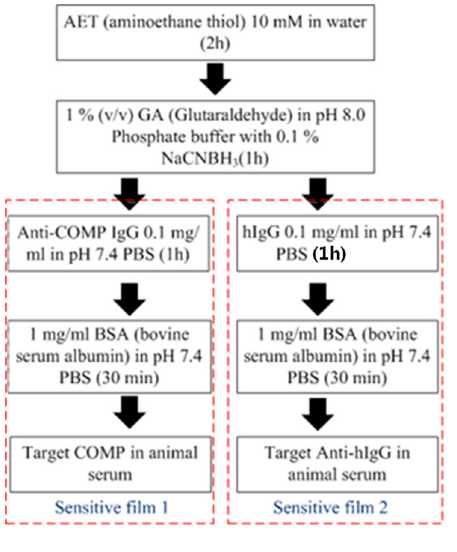
Figure 5. Procedures for two different sensitive film immobilizations.